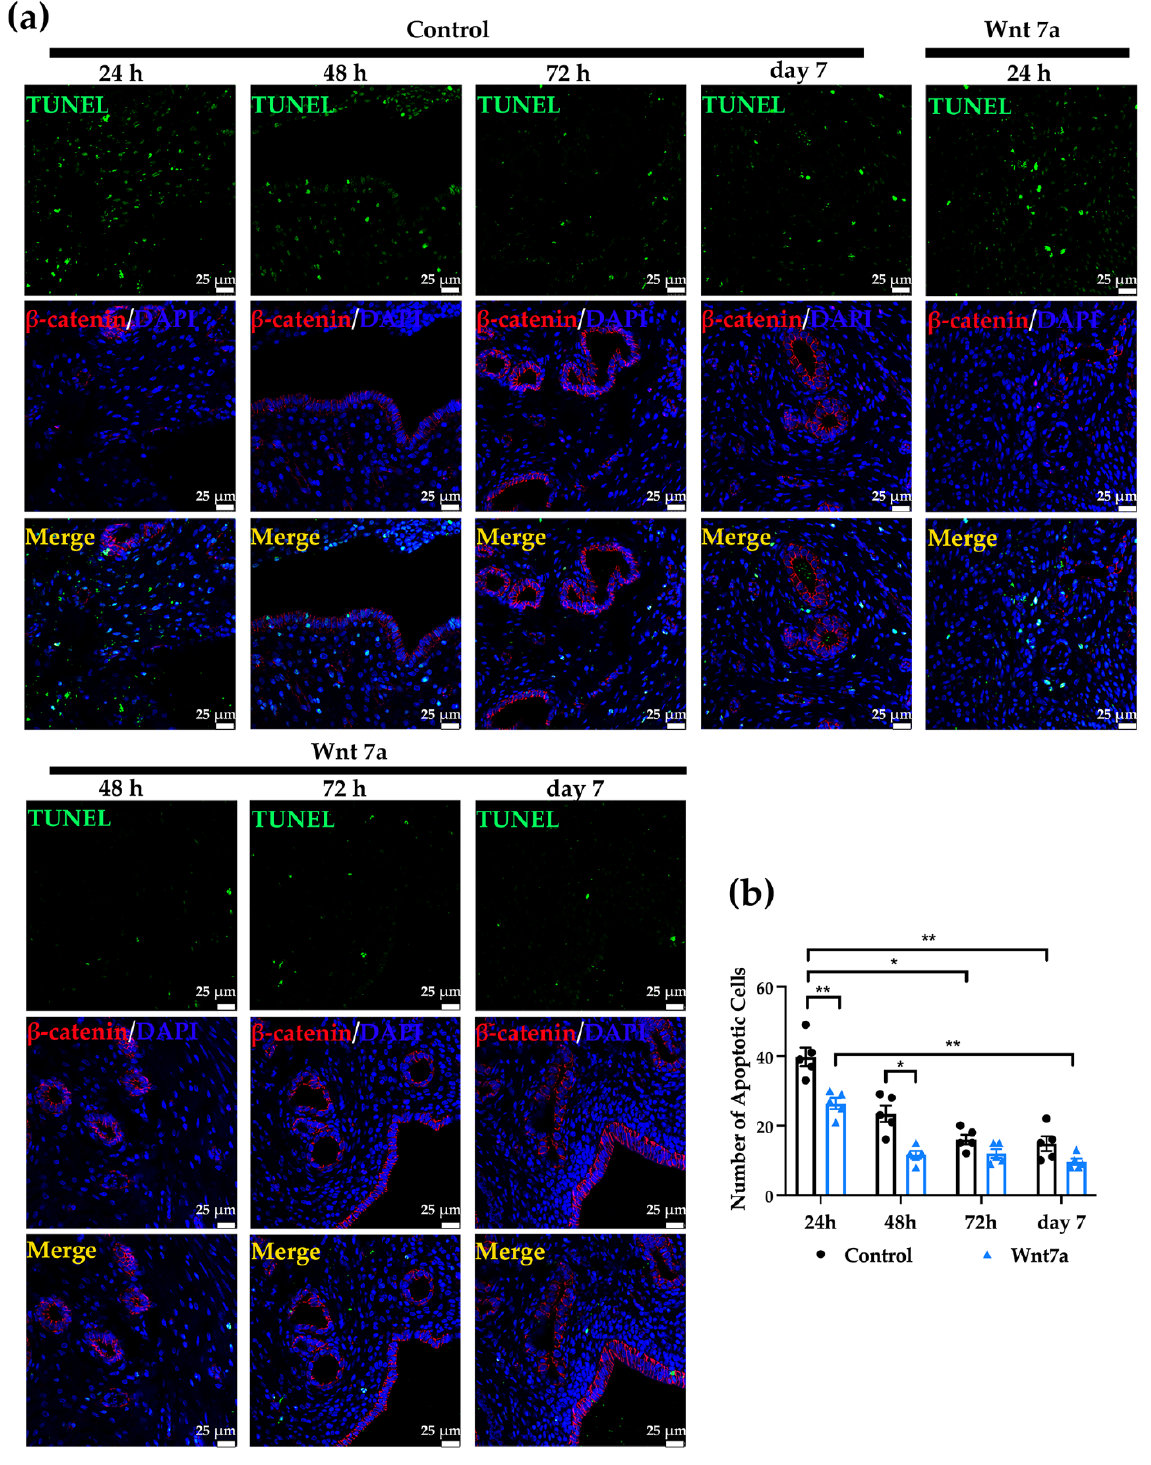
Figure 5. ( a ) The rat uteri were stained with DAPI (blue), TUNEL (green) and anti-non-phosphorylated β -catenin (red) to investigate the number of apoptotic cells and activation of canonical Wnt signaling at 24, 48, 72 h and 7 days after induced injury. Scale bar, 25 μ m. ( b ) The number of apoptotic cells per section at different time after the induced injury is presented in bars. Data are presented as mean ± SEM ( n = 5). * p < 0.05, ** p < 0.01.